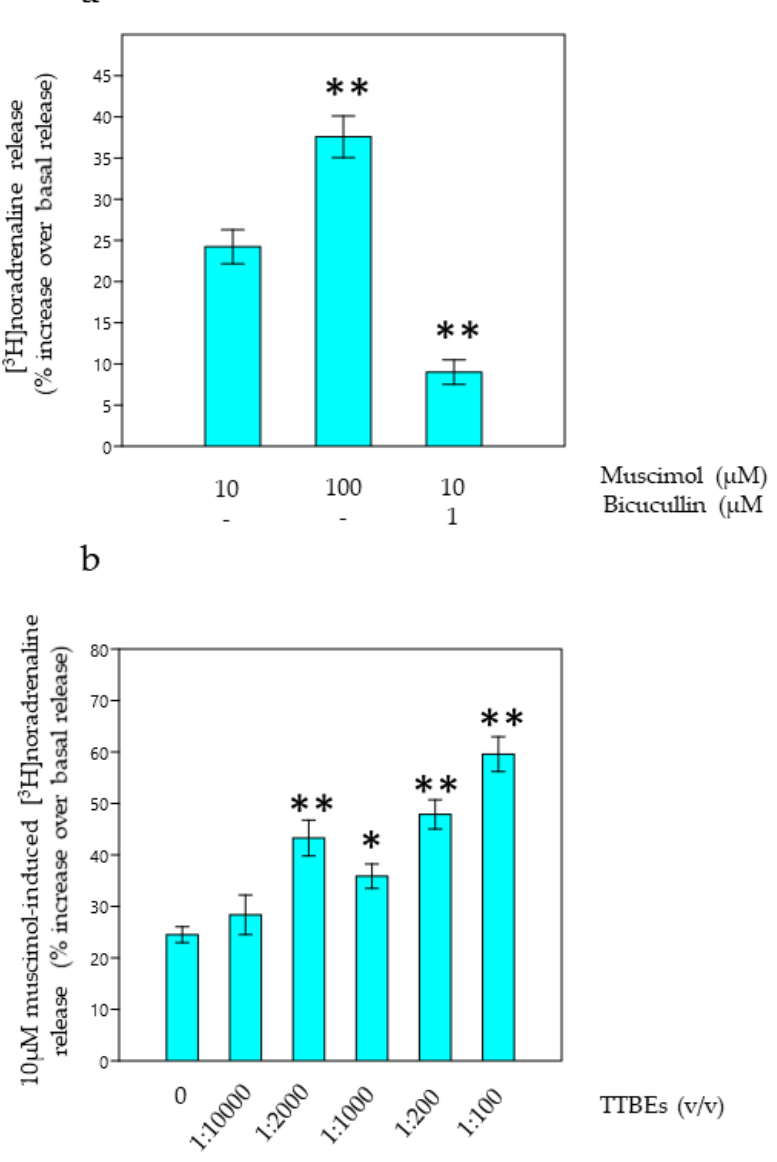
Figure 2. In vitro noradrenaline release from cortical synaptosomes of young male mice: functional activity of native GABAA receptors in presence of TTBEs dilutions. ( a ) Counteracting effect of 1 μ M bicucullin on muscimol evoked [3H]noradrenaline release ( b ). Effects of TTBEs on 10 μ M muscimol evoked [3H]noradrenaline release. Data represent the mean ± S.E.M. from six young male mice. Statistical analysis was performed by applying ANOVA followed by the Tukey’s Multiple Comparison test. * p < 0.05, ** p < 0.01 vs. 10 μ M muscimol. Table 2. Weight gain and water consumption.